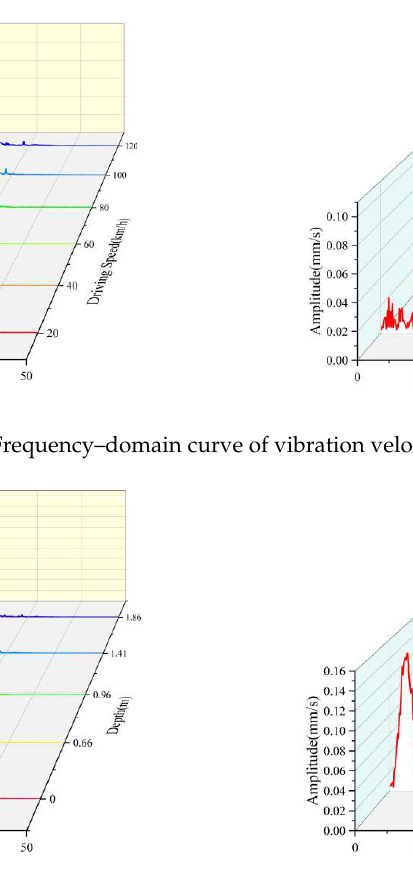
Figure 9. Frequency–domain curve of longitudinal decay of vibration velocity.